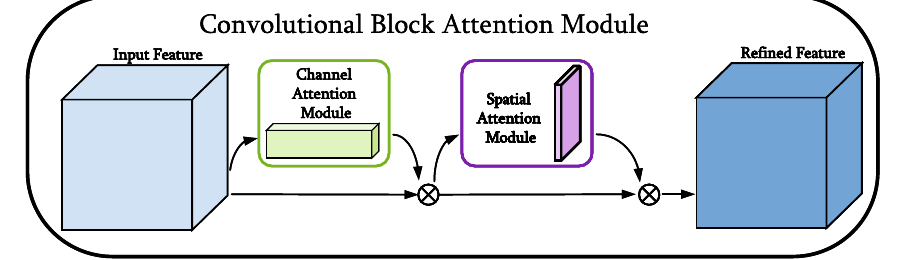
Figure 6. The overview of CBAM attention mechanism module.